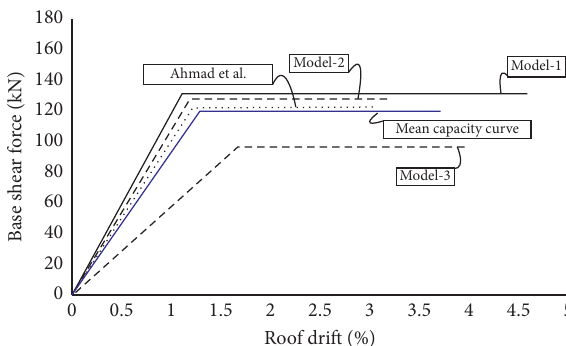
Figure 9: Developed elastic-plastic force-deformation relationships. The frame tested by Ahmad et al. [25] was also considered in the present